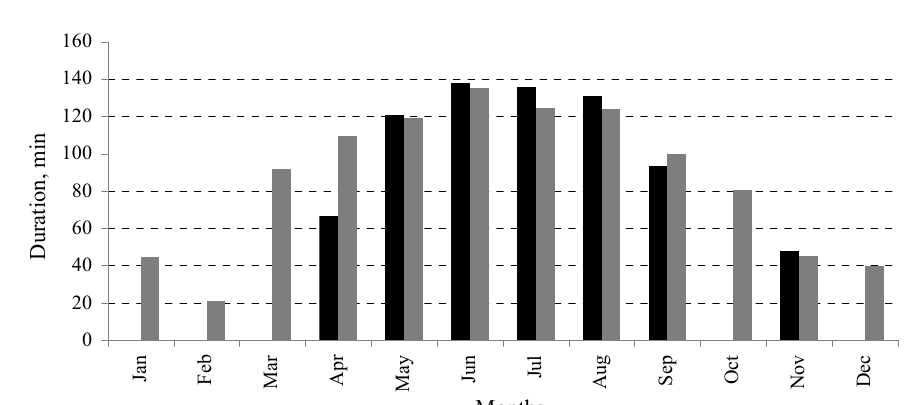
Fig. 6. Mean monthly duration of thunder events in case of southern cyclones (black) and in other thunder events (grey) in